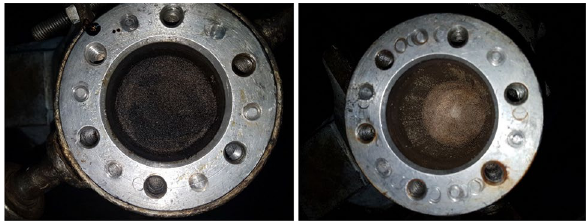
Fig. 11 Photographs of sandpacks after flooding with sea water (left) and the emulsion 60/40 (right) Fig. 12 Differential pressure of the two sides of the models during emulsion